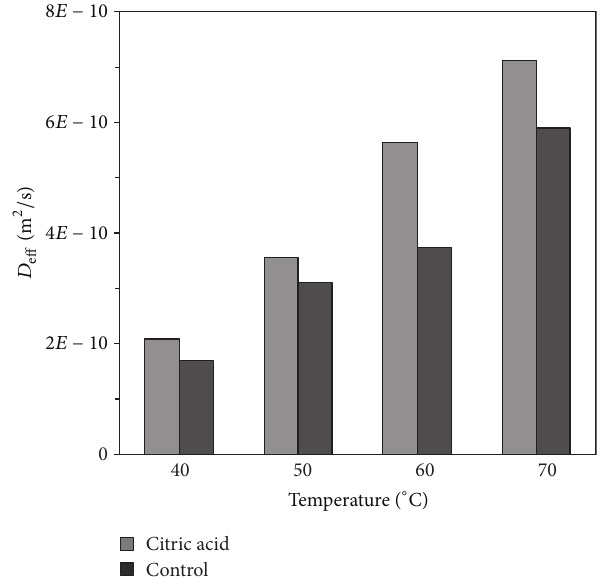
Figure6:Rehydrationratioversustimeatrehydrationtemperatures of 25 and 50 ∘ C for mushroom slices dried at 40 ∘